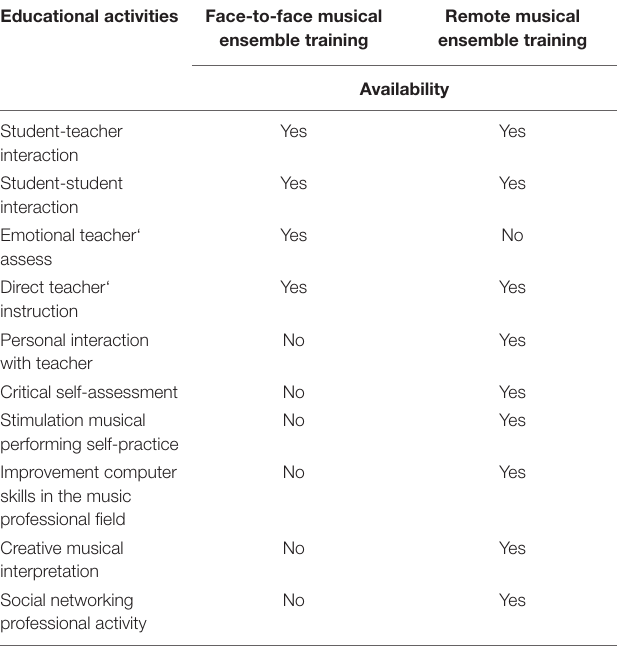
TABLE 8 | A comparison of traditional and online musical ensemble